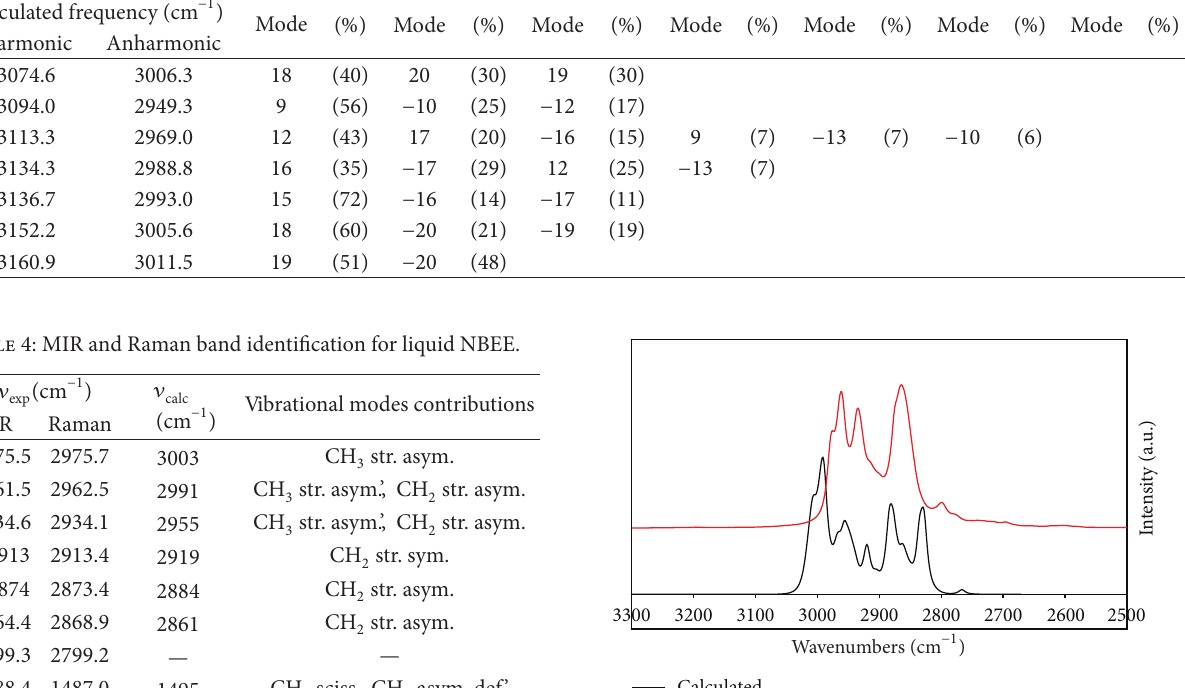
Calculated Experimental F 7: Calculated and experimental spectra of NBEE in the upper MIR range (3300–2500cm